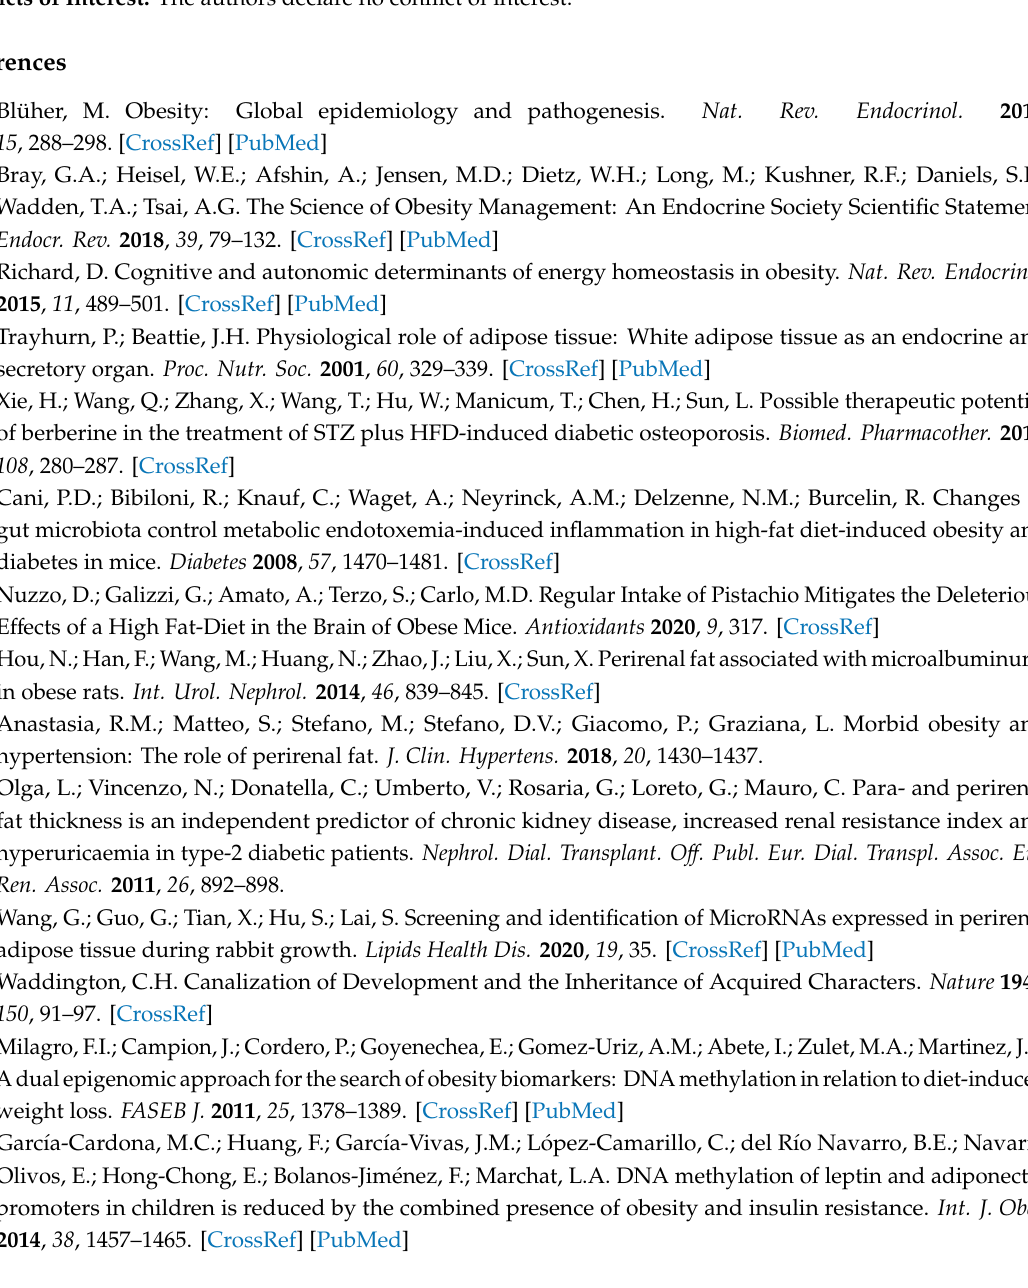
Table S1: Data output and comparative statistics, Table S2: The e ff ective coverage rate of C base in each chromosome, Table S3: The e ff ective coverage rate of C base in di ff erent functional genomic elements, Table S4: Results of genome-wide methylation level analysis, Table S5: Results of the methylation level C, CG, CHG, and CHH on di ff erent chromosomes, Table S6: Methylation level in various functional genomic elements between standard normal diet (SND) and high-fat diet (HFD) group, Table S7: DMRs number and length statistics of standard normal diet (SND) and high-fat diet (HFD) group, Table S8: GO analysis of the overlapping DMRs-associated genes in the gene body regions, Table S9: KEGG pathway analysis of the overlapping DMRs-associated genes in the gene body regions, Table S10: GO analysis of the overlapping DMRs-associated genes in the promoter regions, Table S11: KEGG pathway analysis of the overlapping DMRs-associated genes in the promoter